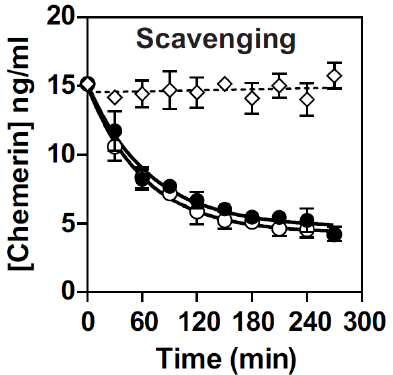
Figure 4. hGPR1 and mGPR1 scavenge chemerin similarly. Mock transfected CHO-K1 cells ( ◇ ) or cells stably expressing hGPR1- R Luc ( ○ ) or mGPR1- R Luc ( ● ) were incubated with 25 nM chemerin for various times and the amount of chemerin remaining in the medium quantified by ELISA. Data represent the mean ± SEM of at least three independent experiments.